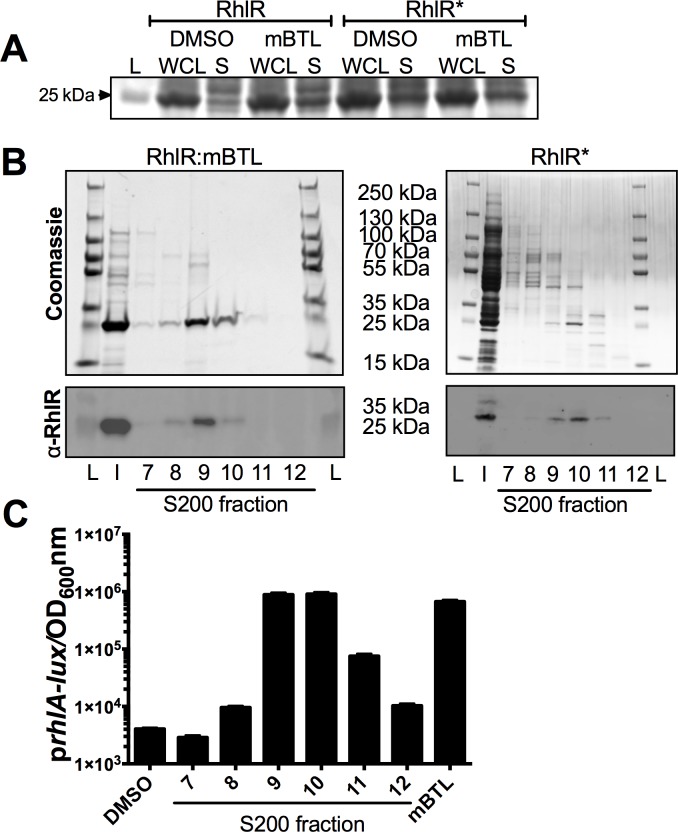
Purification of RhlR:mBTL and RhlR*.A) Total protein comparison of whole cell lysate (WCL) and soluble (S) fractions from E. coli cells overexpressing RhlR or RhlR* in the absence of ligand (DMSO) or in the presence of 100 μM mBTL. “L” denotes ladder and the 25 kDa band is designated. B) The final step in the purification of the full-length RhlR:mBTL and RhlR* proteins. Top: Coomassie stained gels with lanes loaded with 1% total volume from peak fractions 7–12 from the Superdex-200 size exclusion column. Bottom: Immunoblots of the peak fractions from the gels above using an anti-RhlR antibody [14]. “L” and “I” denote ladder and input, respectively. Molecular weight markers are designated in between the gels. C) Activity of the E. coli prhlA-lux reporter strain (see Fig 1) in response to released mBTL from purified RhlR protein. The assay was carried out as described for Fig 1. As controls, 1% DMSO (no autoinducer; left-most bar) was added and pure mBTL (right-most bar) was assayed at 10 μM. The amount of mBTL released from the purified proteins in peak fractions 9 and 10 was sufficient to saturate the reporter strain, resulting in nearly equivalent levels of light production even though there were different amounts of protein in each fraction.